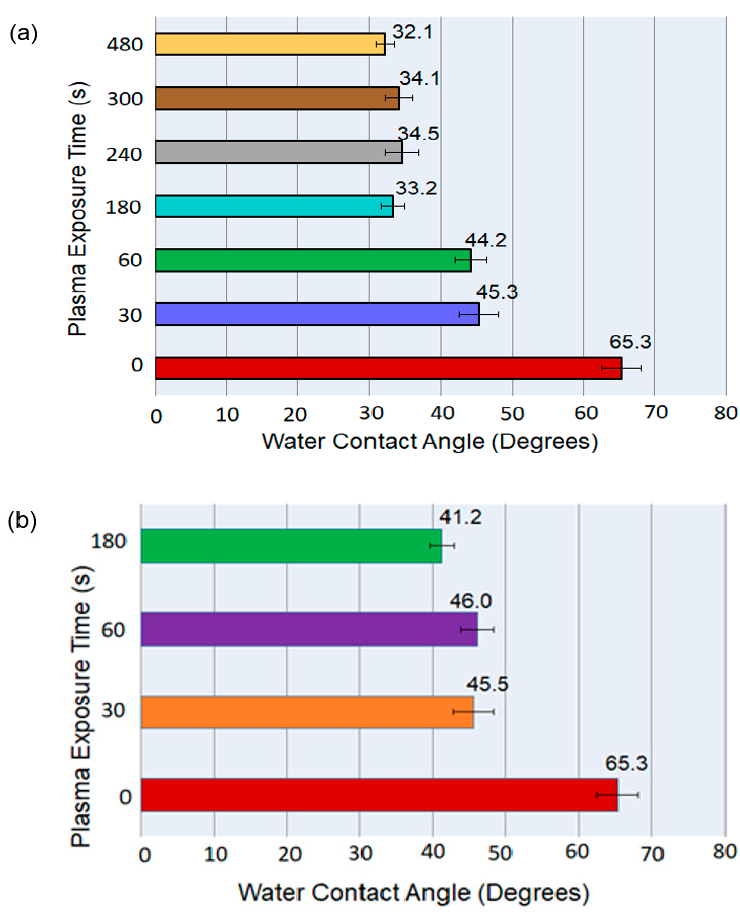
Figure 6. Average WCA measurements of ( a ) fresh He/H 2 O and ( b ) He/5% O 2 plasma-treated nylon films for different durations. The average WCA of each sample is specified. The sample denoted 0-s plasma exposure time refers to the untreated pristine nylon film for both